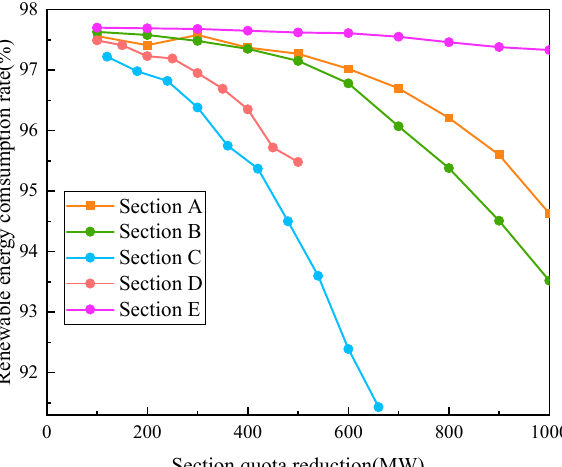
Figure 3. Sensitivity analysis of maintenance factors based on the renewable energy consumption rate.